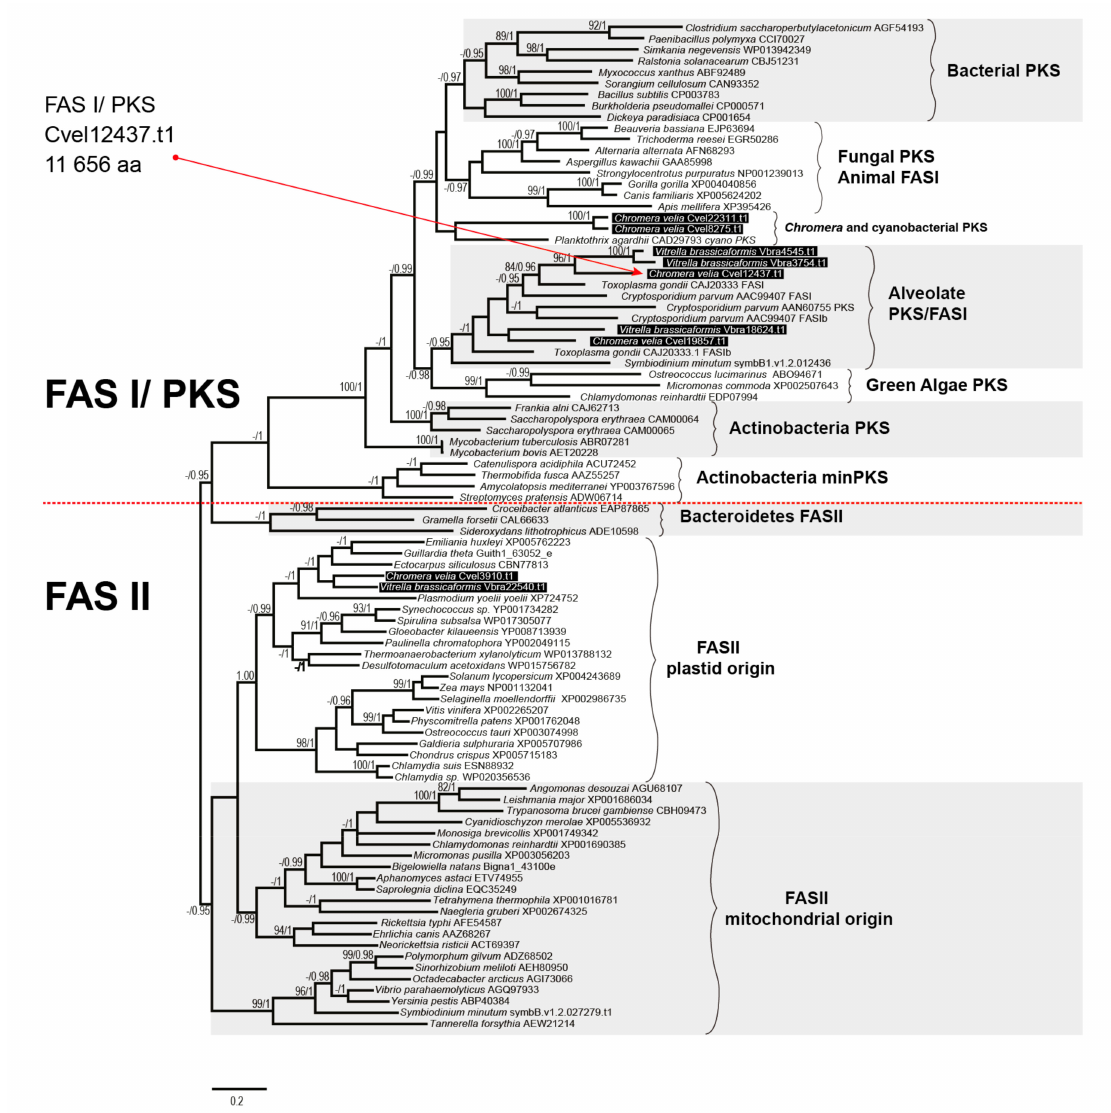
Figure 2. The phylogenetic tree as inferred from ketoacyl synthase domains to distinguish type I and type II fatty acid synthases. Bootstrap for 1000 repetitions and Bayesian pp values (BS1000 / 1M, CAT / LG models) are displayed above or below the branches. FAS, fatty acid synthase, PKS, polyketide